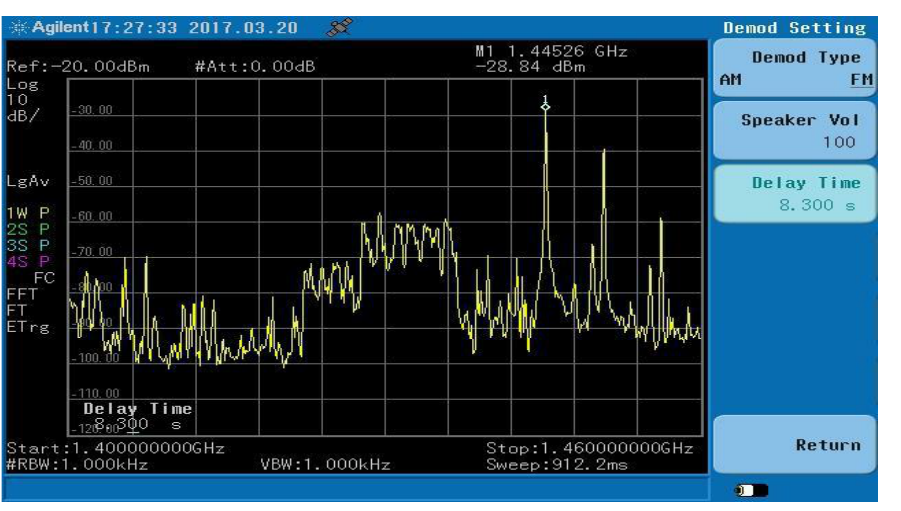
Figure 16. Measurements from transmission point of an interference due to a TV/Radio broadcasting system, frequency 1408.28 MHz, signal level − 79 dBm. (Courtesy of AKEP Albania).